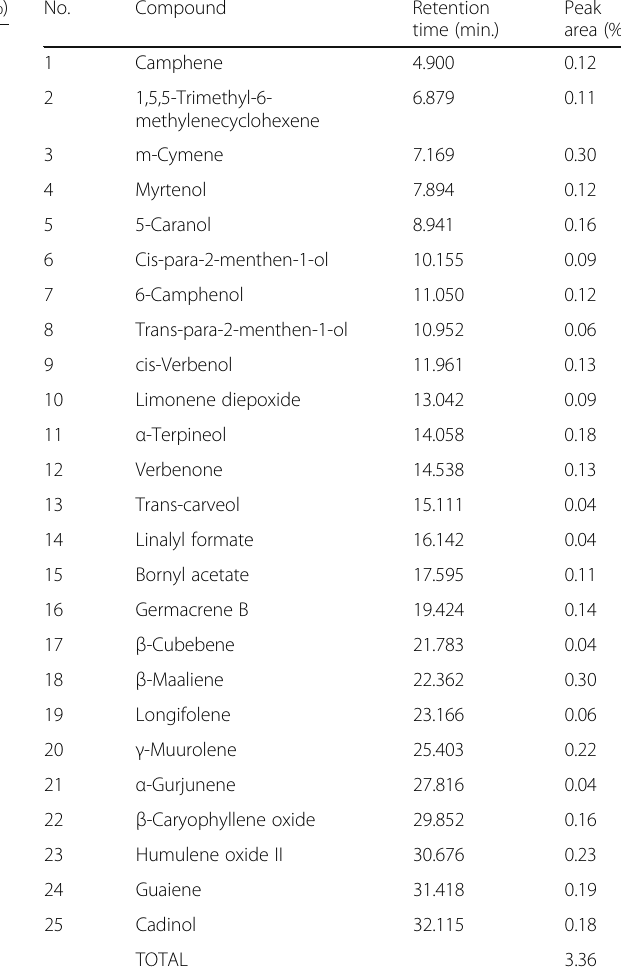
Table 3 Major and minor compounds identified by GC-MS in the juniper extract (over 0.3% peak area)